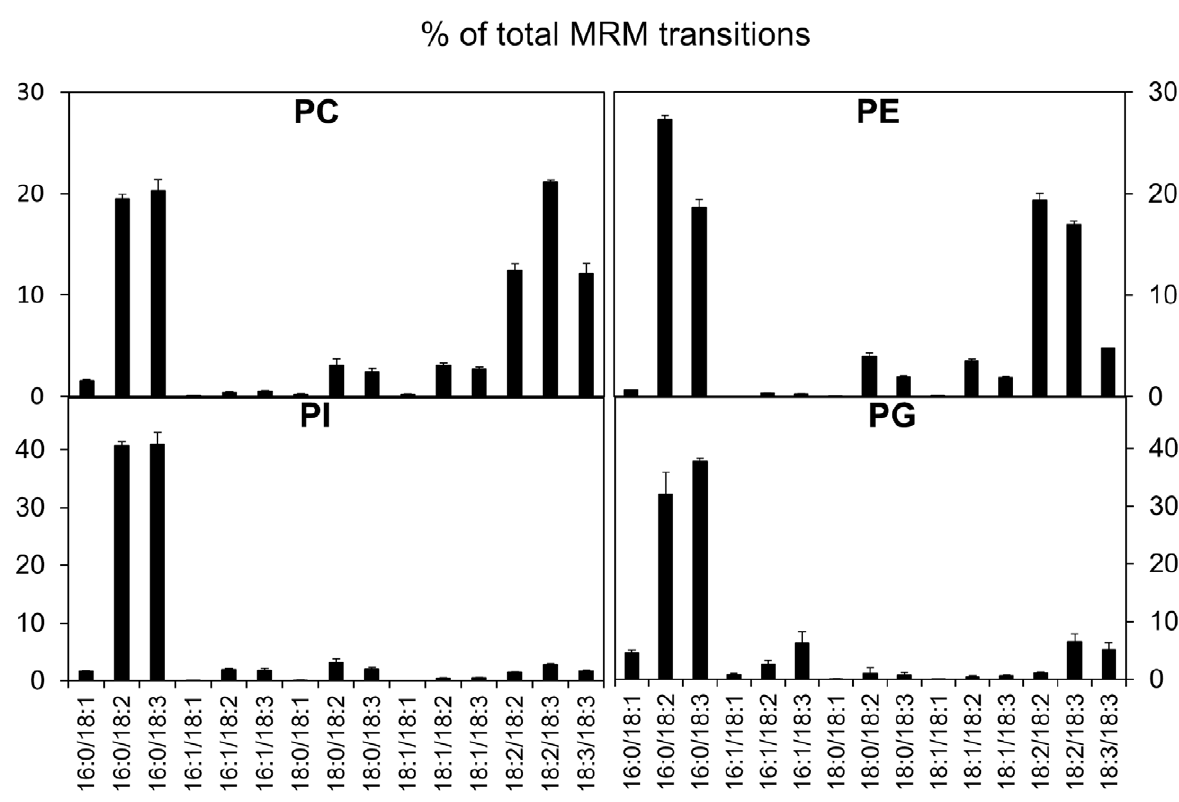
Figure 2. Analysis of the main glycerophospholipids in Arabidopsis cells by MRM mass spectrometry. Lipids were analyzed, searching for the transitions listed in Table